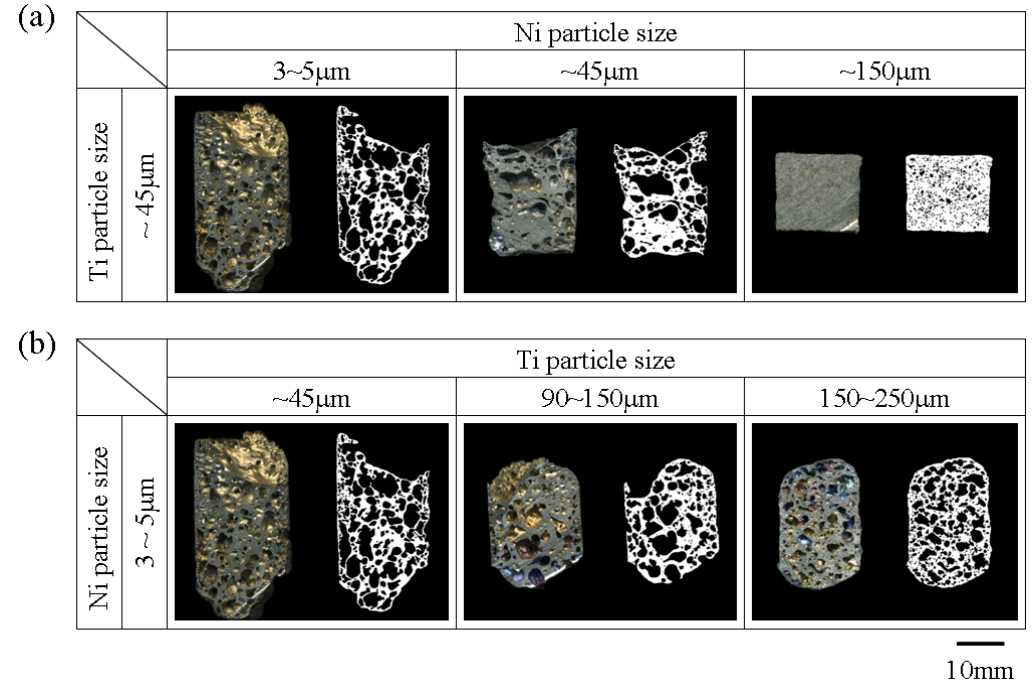
denomination is for both fine. 2